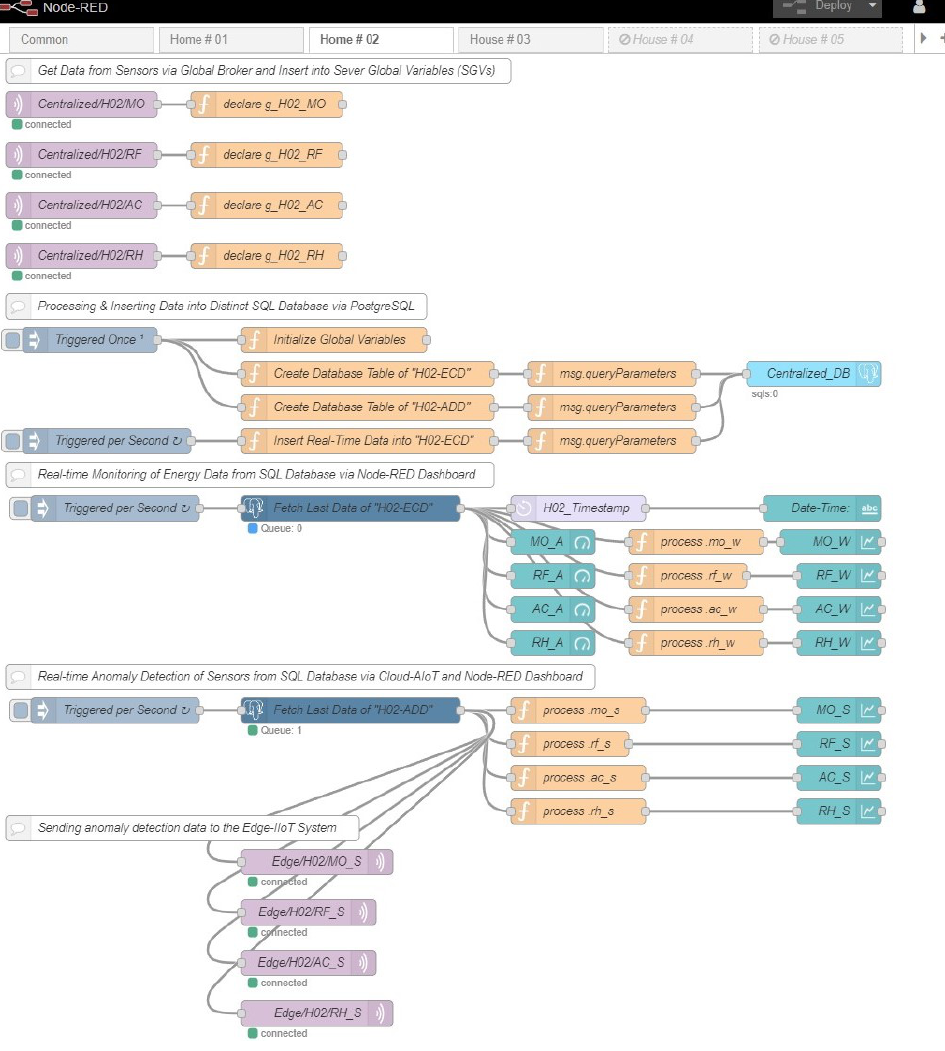
Figure 4. Development of the centralized IIoT